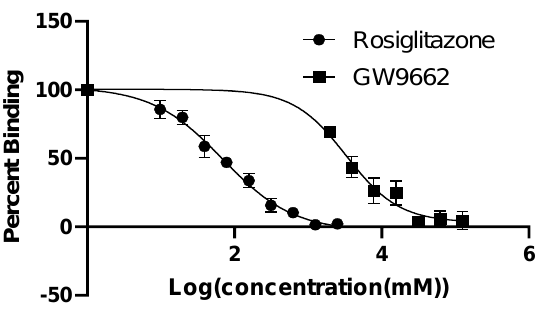
Figure 3. PPAR γ ligand binding. PPARγ binding of rosiglitazone (circle) and GW9662 (square) was determined by an in-vitro ligand screening assay kit. The four-parameter logistic regression (4PL) model was used to fit the curves with GraphPad Prism 9.0(GraphPad Software, San Diego, CA, USA).